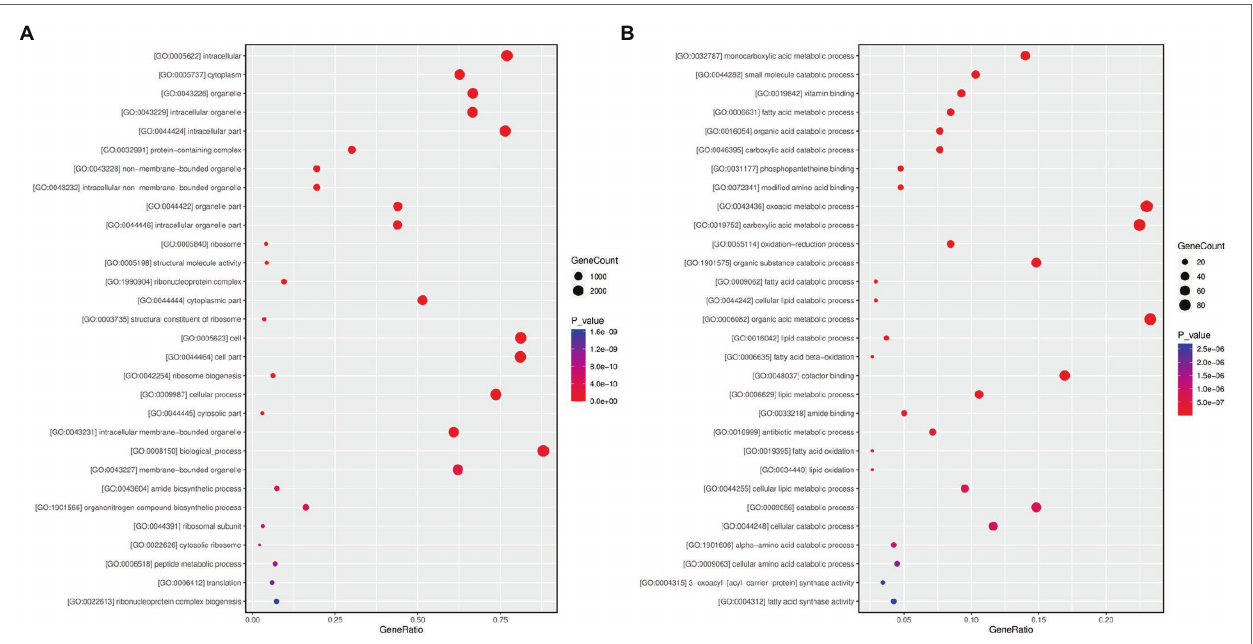
FIGURE 6 | Bubble diagram of differentially expressed genes (DEGs) GO functional enrichment analysis. (A) S. sclerotiorum DEGs in paired comparison of Gm-Ba- Ss vs. Gm-Ss; (B) B. amyloliquefaciens DEGs in paired comparison of Gm-Ba-Ss vs. Gm-Ba. Gm-Ba, Gm-Ss, Gm-Ba-Ss indicated that the Glycine max seedling were inoculated with B. amyloliquefaciens , S. sclerotiorum and their mixture, respectively. The abscissa represents GeneRatio, that is, the proportion of the DEGs belonging to a certain GO term in all the DEGs. The larger the bubble is, the more differentially expressed genes are. Color represents the significance of enrichment, that is, p -value. The darker the color, the more significant the enrichment of the GO term. The color gradient on the right represents the value of p